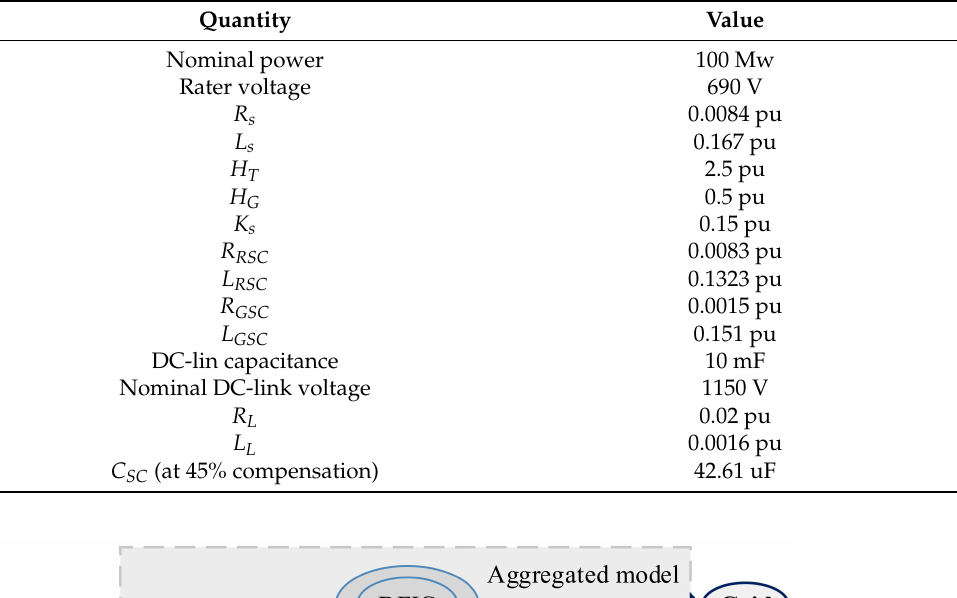
to Table 1. The schematic diagram of the proposed VGSTSM damping control scheme is depicted as Figure 2. Firstly, the sliding mode functions were calculated, then the auxiliary control quantities were obtained according to the adaptive law and super-twisting sliding mode control laws, and finally the RSC control signals were obtained through the feedback control. Control parameters were chosen as ε q = 0.001, γ q = 2.2, b q = 2.0, ε d = 0.001, γ d = 2.5, and b d = 2.3. Table 1. Series-compensated DFIG-based wind power system parameters.